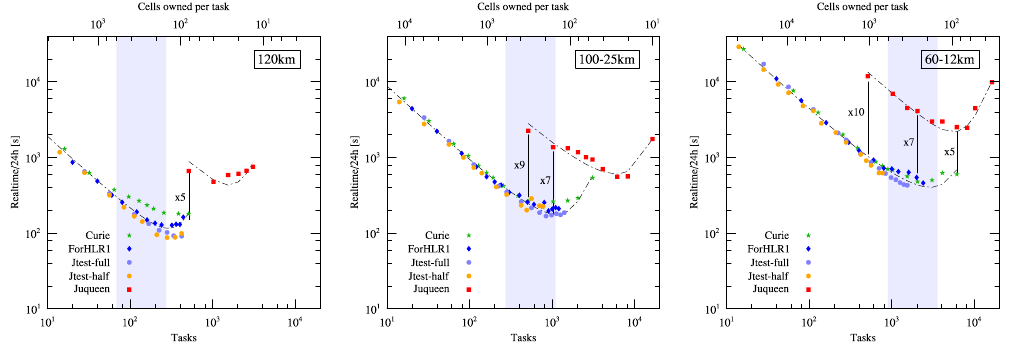
Figure 6. Total run times (s) for the 120km regular mesh with 40962 grid cells, the variable 100–25km mesh with 163842 grid cells and the variable 60–12km mesh with 535554 grid cells. Indicated are time ratios between the Linux-cluster systems Curie, ForHLR1 and Juropatest, and the Blue Gene system Juqueen. Fits to the total run times are obtained separately for the Linux-cluster systems and the Blue Gene system, using a modified version of Amdahl’s law (see Eq. 2 and Table 2), and are displayed as dashed black lines.